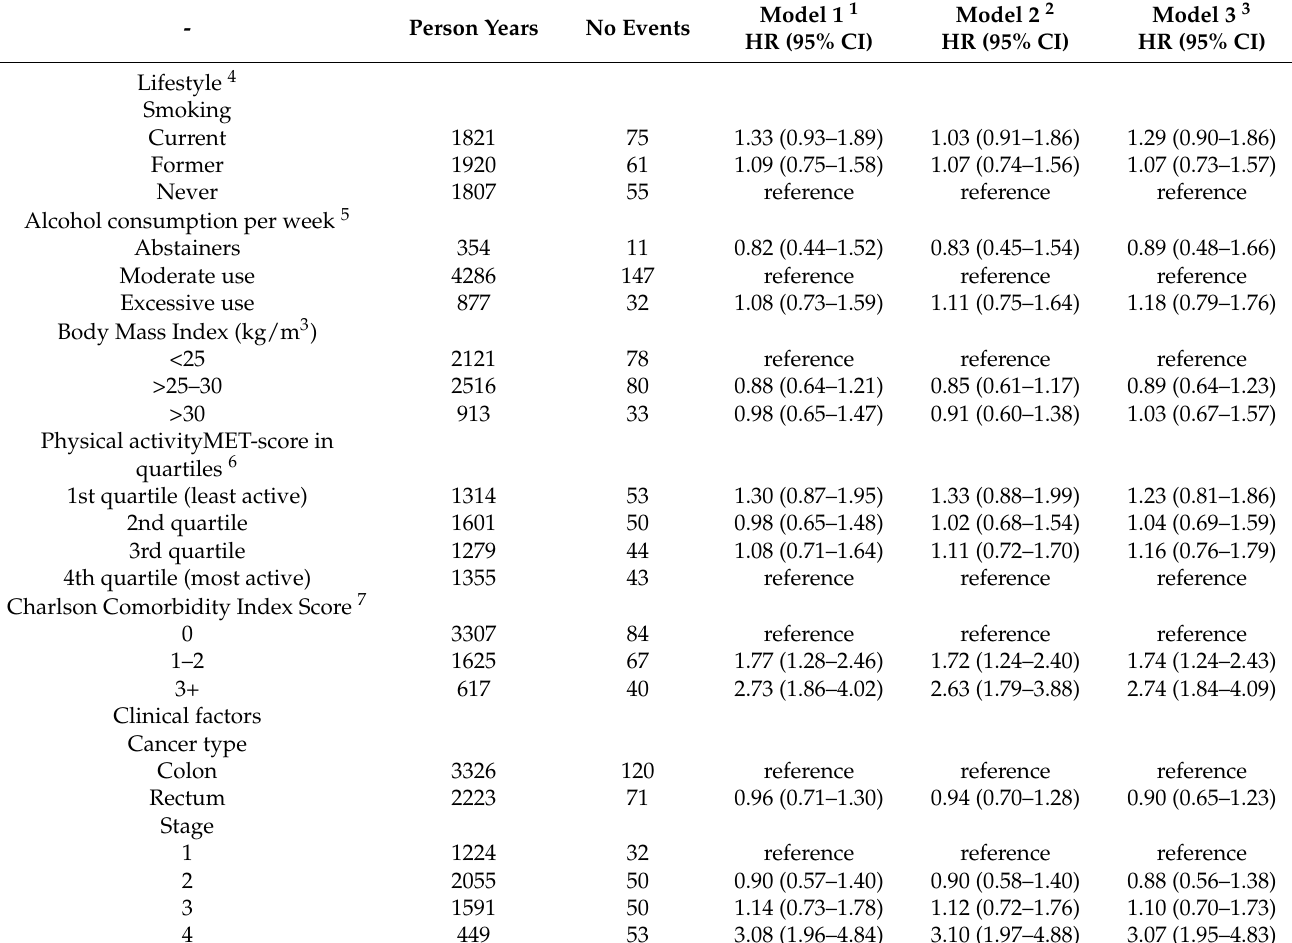
Table 4. Lifestyle, clinical and treatment related risk factors for depression for 1324 patients with colorectal